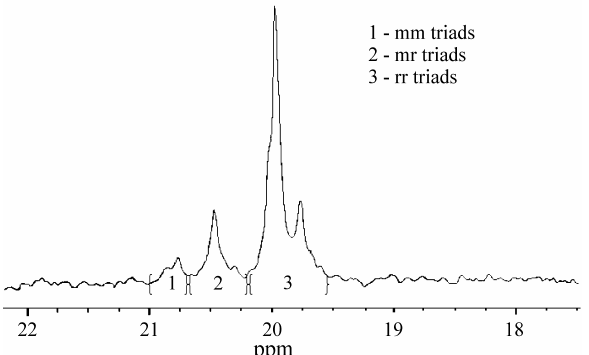
Figure 1. 13 C-NMR Spectrum of syndiotactic polypropylene obtained by the Et(Flu)(Cp)ZrCl 2 /MAO catalytic